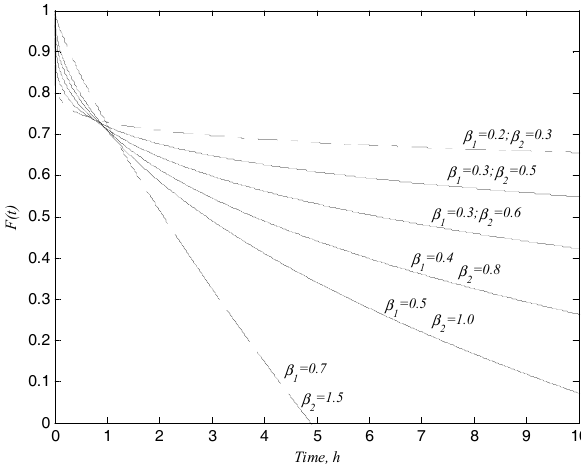
Figure 2. The facilitating role of β 2 overtaking β 1 in increasing the flow rate when both orders increase. The illustration of Equation (14) with pairs of 2 β and 1 β (the joint parameter